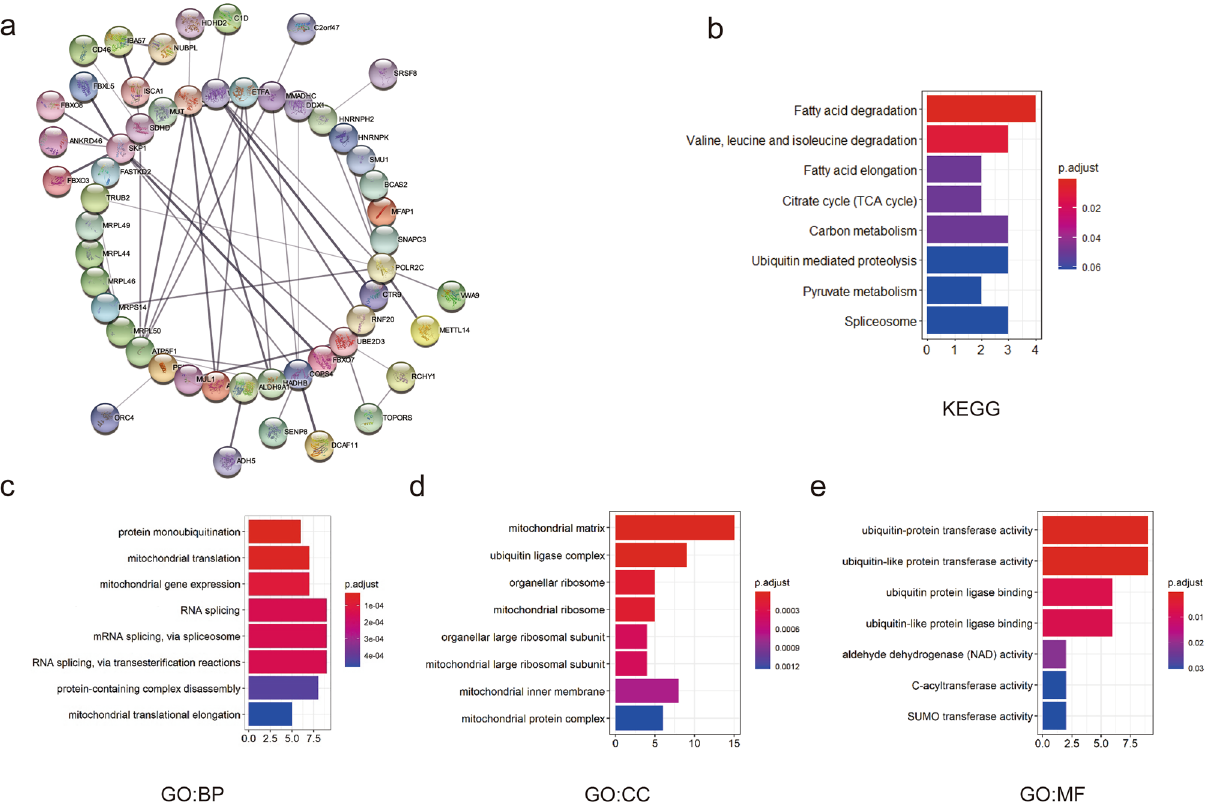
Figure 8. GO and KEGG enrichment analysis of the co-expression genes in KIRC patients. ( a ) The network of 100 most similar MMDS related iron–sulfur protein genes. The functions of the 100 most similar genes by ( b ). KEGG enrichment analysis, ( c ) GO biological processes, ( d ) GO cellular components, and ( e ) GO molecular